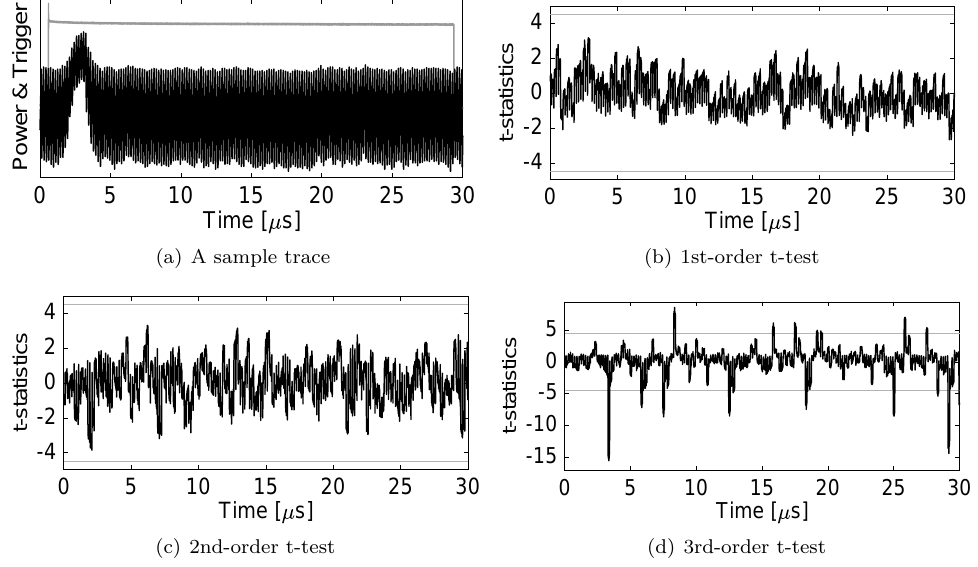
Figure 10: FPGA-based fixed versus random t-test using 100 million traces, Skinny-64-64 round-based encryption, second-order HPC2 Naive